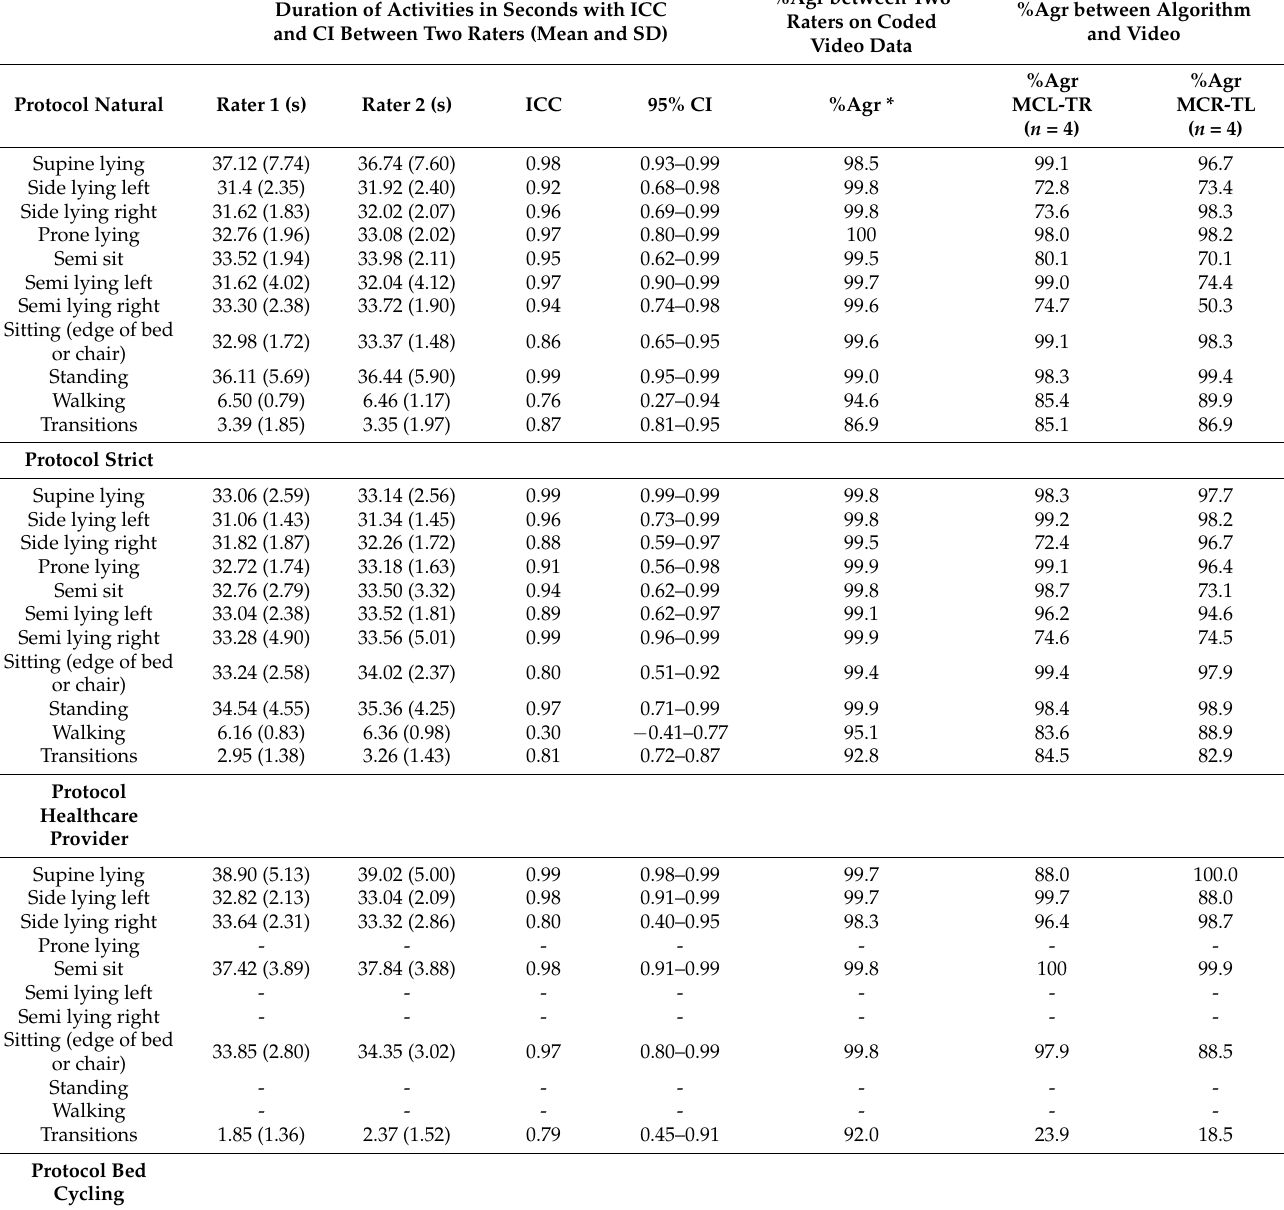
Table 1. Interrater reliability of video analysis, percentage agreement between two raters on the coded activities, and percentage agreement of the algorithm related to the video on the development group